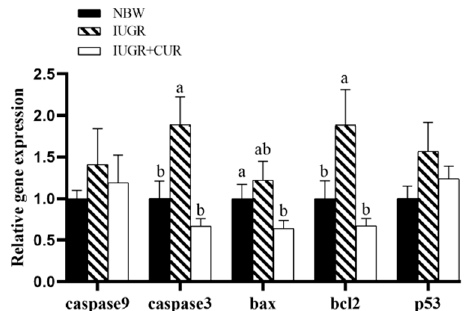
jejunal mucosa. Data are normalized to the NBW group and expressed as mean ± SE (n = 6); a, b means